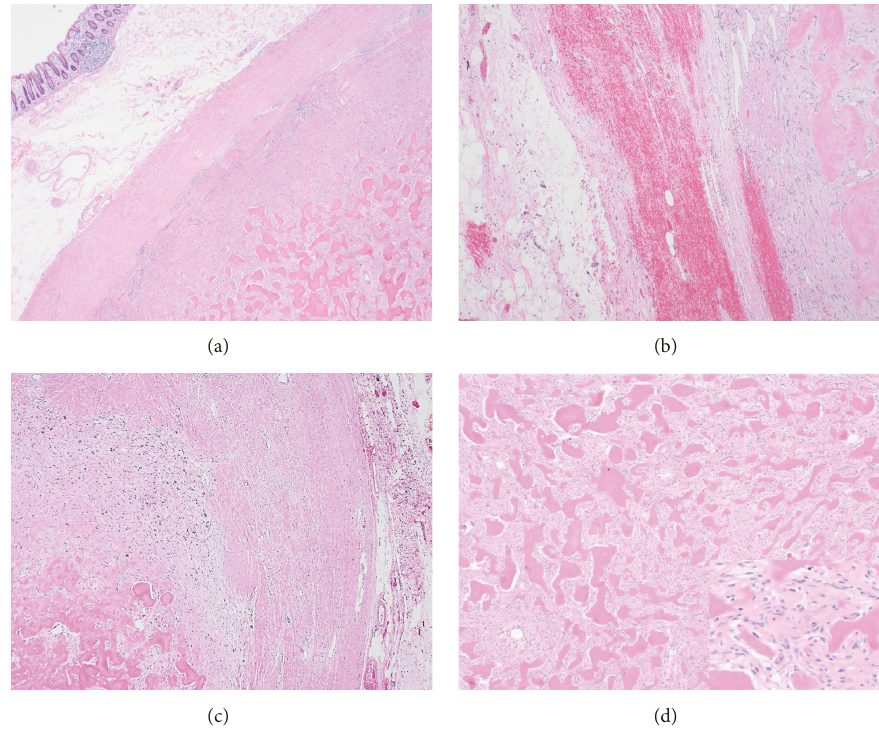
Figure 2: (a) A low power image showing dedifferentiated liposarcoma with osseous differentiation involving the colonic wall (20X). (b) Dedifferentiated liposarcoma with osseous differentiation adjacent to well-differentiated liposarcoma (left) (20X). (c) Dedifferentiated liposarcoma with osseous differentiation and highly atypical cells (40X). (d) Areas of low-grade osteogenic differentiation with well-formed bone trabeculae and intervening spindle cells (40X). The insert shows high power image of the spindle cells with mild atypia